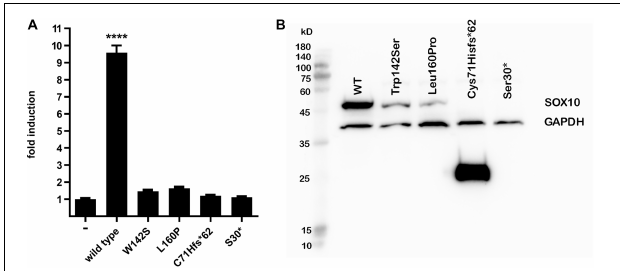
FIGURE 3 | MITF transactivation activity and western blot. (A) MITF transactivation (TA) activity. Note 9.5-fold induction of TA activity by wild-type SOX10 compared with empty vector; nearly complete loss (2%) of TA activity of Cys71Hisfs*62 and Ser30*, and 1.5-fold and 1.7-fold induction by Trp142Ser and Leu160Pro compared with empty vector (i.e., 6 and 8% of wild-type control after deduction of activity of empty vector, respectively). Results shown are representative of at least three independent experiments (**** p < 0.001 by one-way ANOVA). (B) Western blot analysis. From left to right: molecular size marker, wild-type SOX10, Trp142Ser and Leu160Pro variants of normal predicted size at 51 kD, Cys71Hisfs*62 25 kD, and undetectable Ser30* at 3.1 kD. Note marked reduction in proteins compared with wild-type for Trp142Ser (30% residual protein) and Leu160Pro (11% residual amount) and increase for Cys71Hisfs*62 variant (500%). GAPDH was used as a loading control for normalization for wild-type SOX10 and each variant. Note similar GAPDH levels in all lanes. Image brightness and contrast not modified from original. Size marker: PM2510, ExcelBand, SMOBIO.